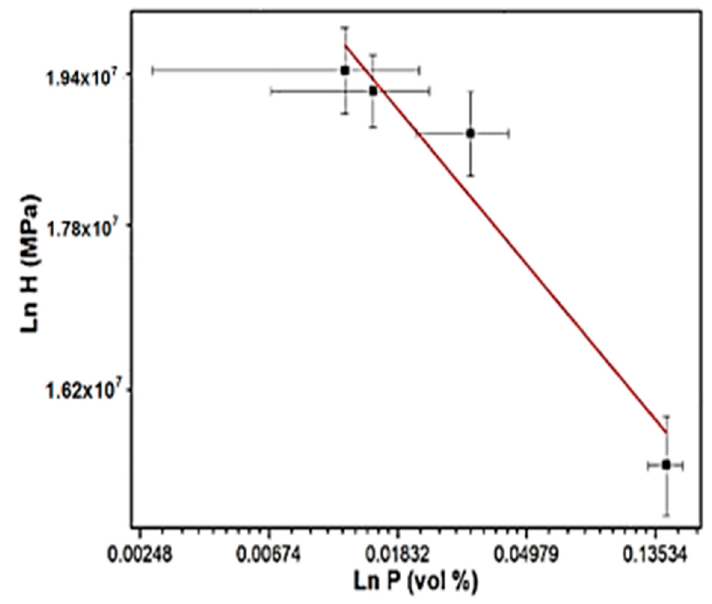
Figure 2. Ln microhardness vs. Ln porosity of NiTec coatings.